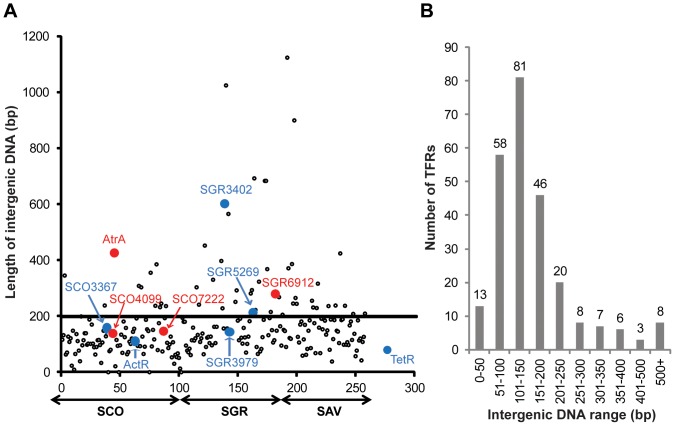
Length of intergenic DNAs between TFRs and their divergent neighbors.(A) Each of the 250 TFRs having divergent neighbors in SCO, SGR, and SAV is represented as a dot with the value on y-axis indicating the length of the intergenic sequence between its own gene and divergent gene. On x-axis, the TFRs are placed in the order of their gene annotations along the length of the linear chromosomes (the host streptomycete is stated below). The larger colored dots correspond to the TFRs investigated in this study (see Table 1 and text for details). A model TFR, TetR, is shown on the graph as a reference. Blue dots indicate the TFRs whose divergent neighbors encode putative membrane transporters, while the TFRs represented by red dots are adjacent to genes encoding putative enzymes. (B) The TFRs having divergent neighbors are grouped according to the range of their intergenic DNA length.